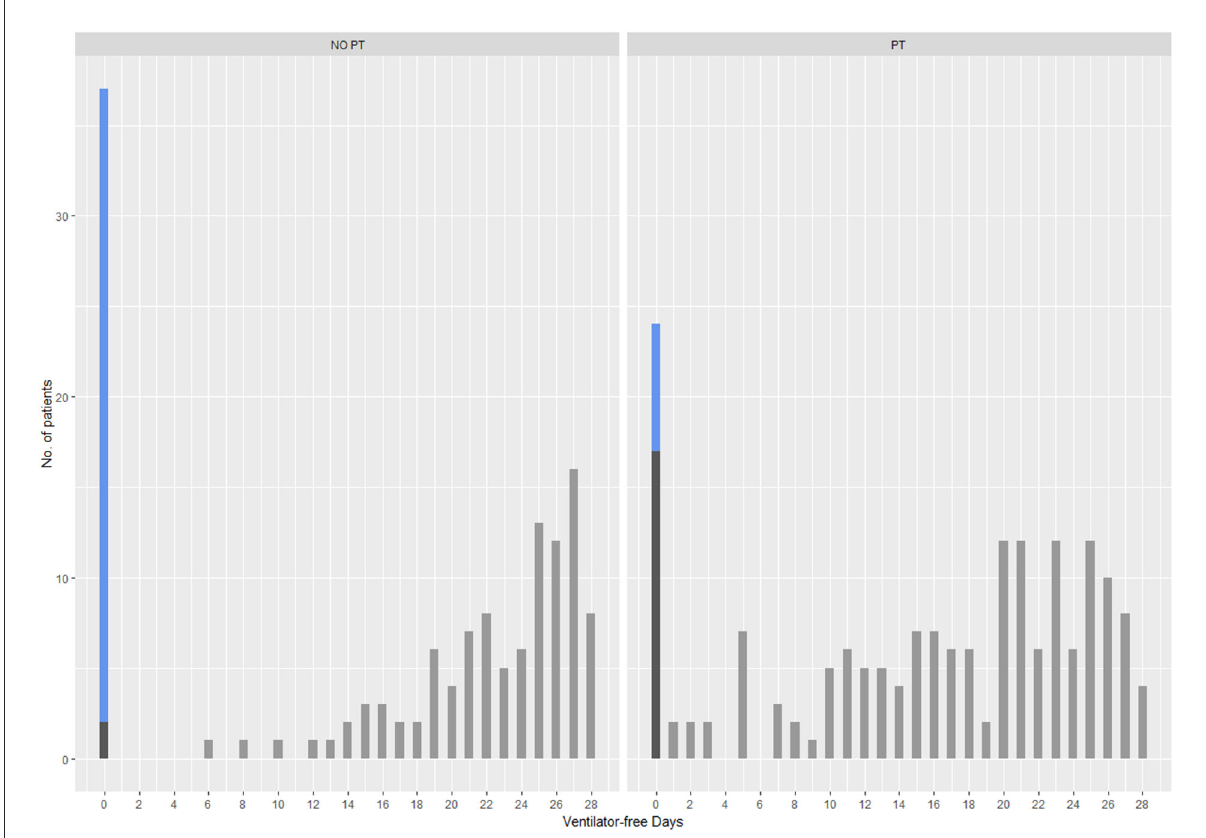
FIGURE2 Distributions of VFDs between patients treated (PT) or not (NO-PT) by physiotherapists at 28 days. Blue bars denote patients who died (VFD = 0), dark gray bars denote patients alive with VFD = 0 and light gray bars identify patients alive with VFDs >